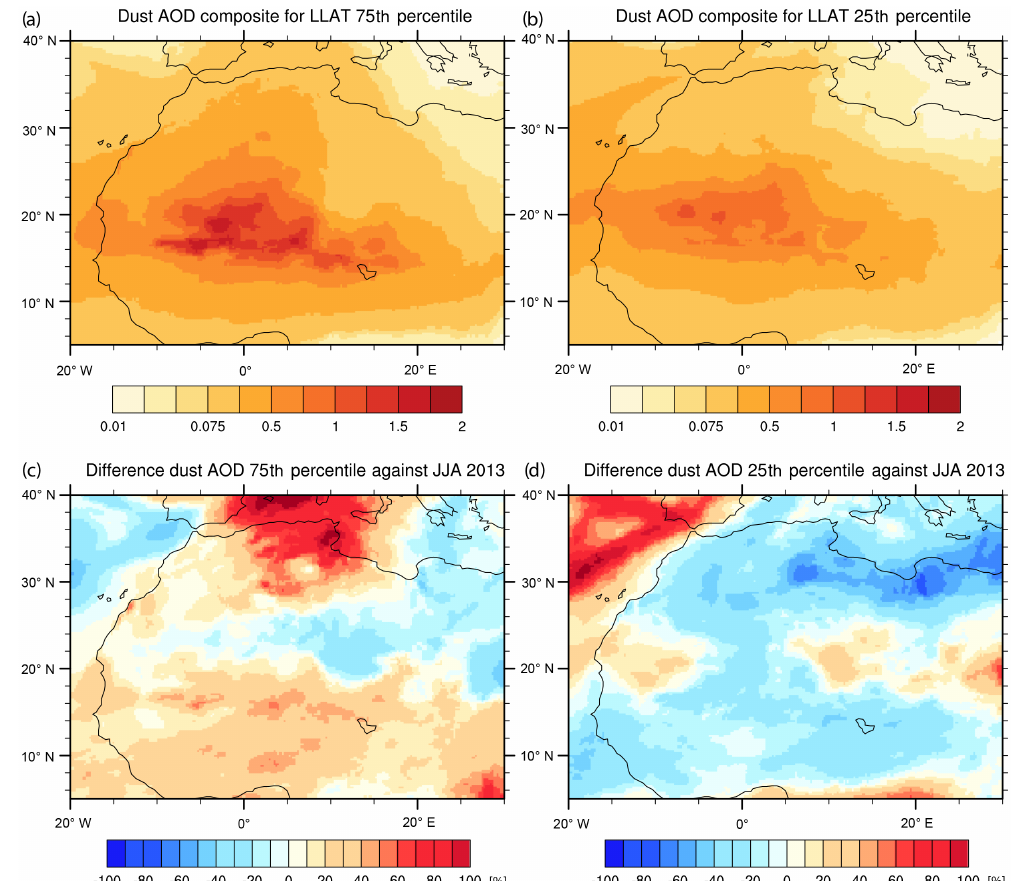
Figure 10. Composite of dust AOD for the days corresponding to the 75th percentile (a) and 25th percentile (b) of the LLAT. See Fig. 9 for the assignment of the days to the 25th and 75th percentile; panels (c) and (d) show the relative difference to the JJA 2013